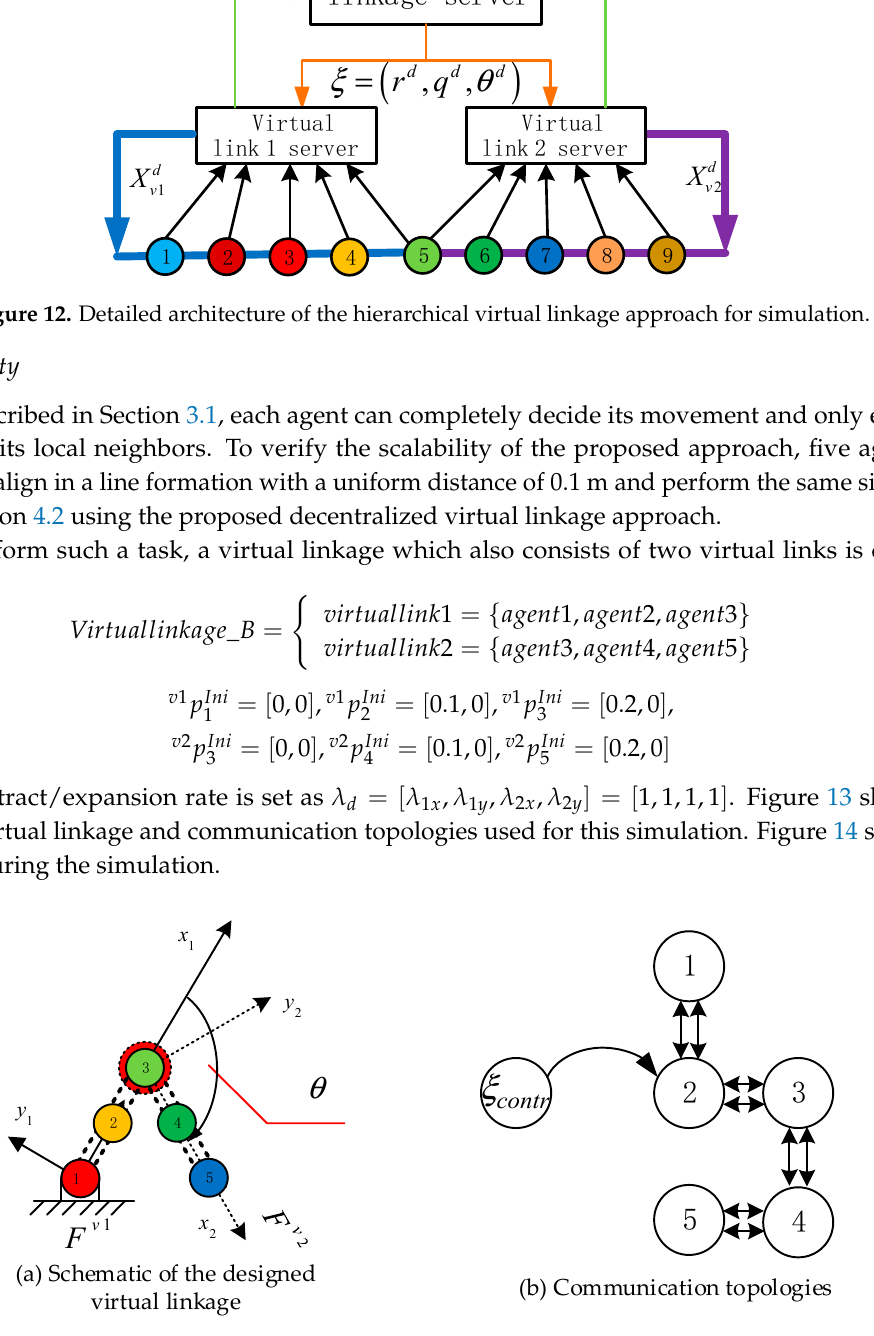
Figure 13. Schematic of designed virtual linkage and communication topologies.